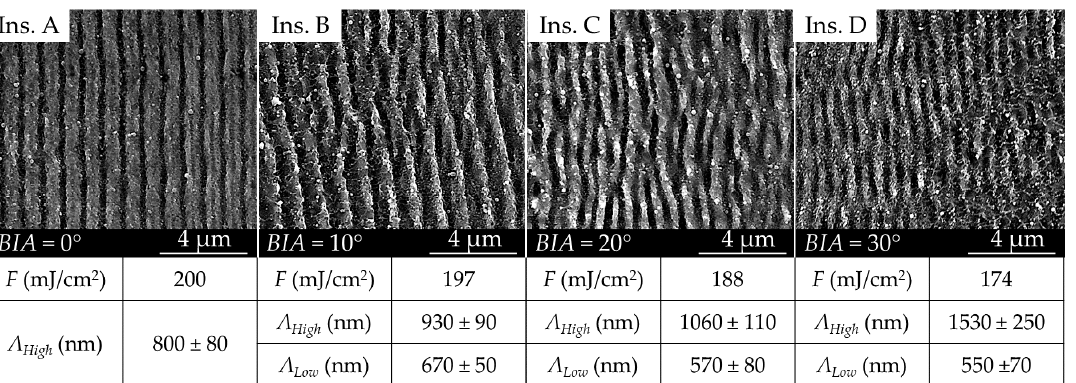
Figure 4. ( a ) Observation direction of the water droplets on the textures surface; ( b ) layout of the wetting test setup; ( c ) estimation of the contact angles through the fitting of the droplet shape. The green square defines the searching area that the software keeps.